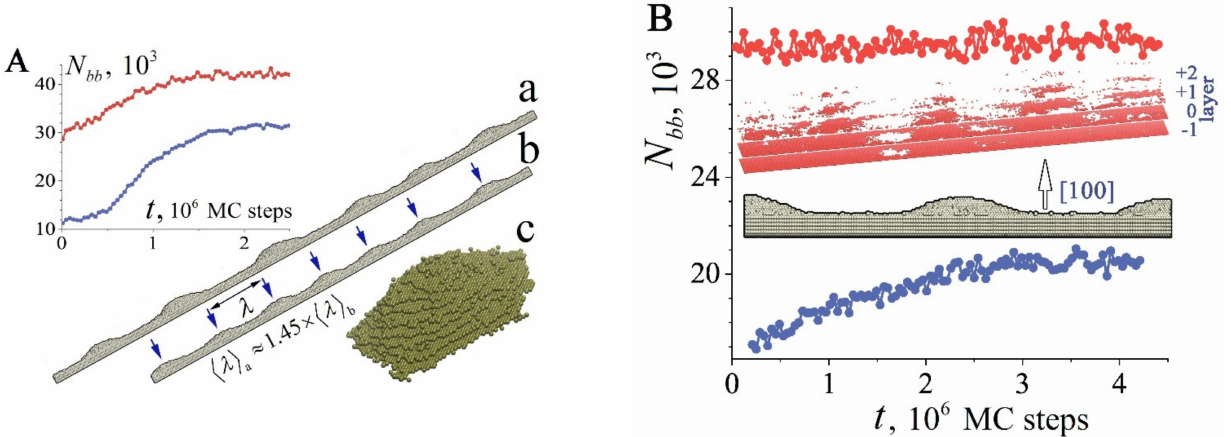
Figure 5. Effect of possible surface heating on the manifestation of stimulated roughening transition on faces of different orientations: ( A ) the outer surface of the plate is a (111)-type facet. The upper inset shows the number of broken bonds (relative to the initial state), N bb ( t ) , in the cold ( p = 0.825, α = 1 —blue curve) and hot ( p = 0.825, α = 0.75 —red curve) regimes. Configurations (a, b) quasi-steady state of the plate surfaces in hot regime with lengths L = 700 and 550 (in both cases w = 70, h = 10 ). The lower inset shows one of the hillocks formed on the upper face of the plate (a); ( B ) results for (100)-orientation of the upper face of the plate. L = 550, w = 70, h = 10. The blue and red circles show time dependencies, N bb ( t ) , for cold and hot regimes, respectively. In the cold regime, six hillocks with a height of 8–10 atomic layers are formed on the upper plane. The bottom inset presents a fragment of the plate. In the hot regime, only two or three near-surface atomic layers are partially filled (upper inset). The observed low structuredness of the surface is characterized by longer wavelength